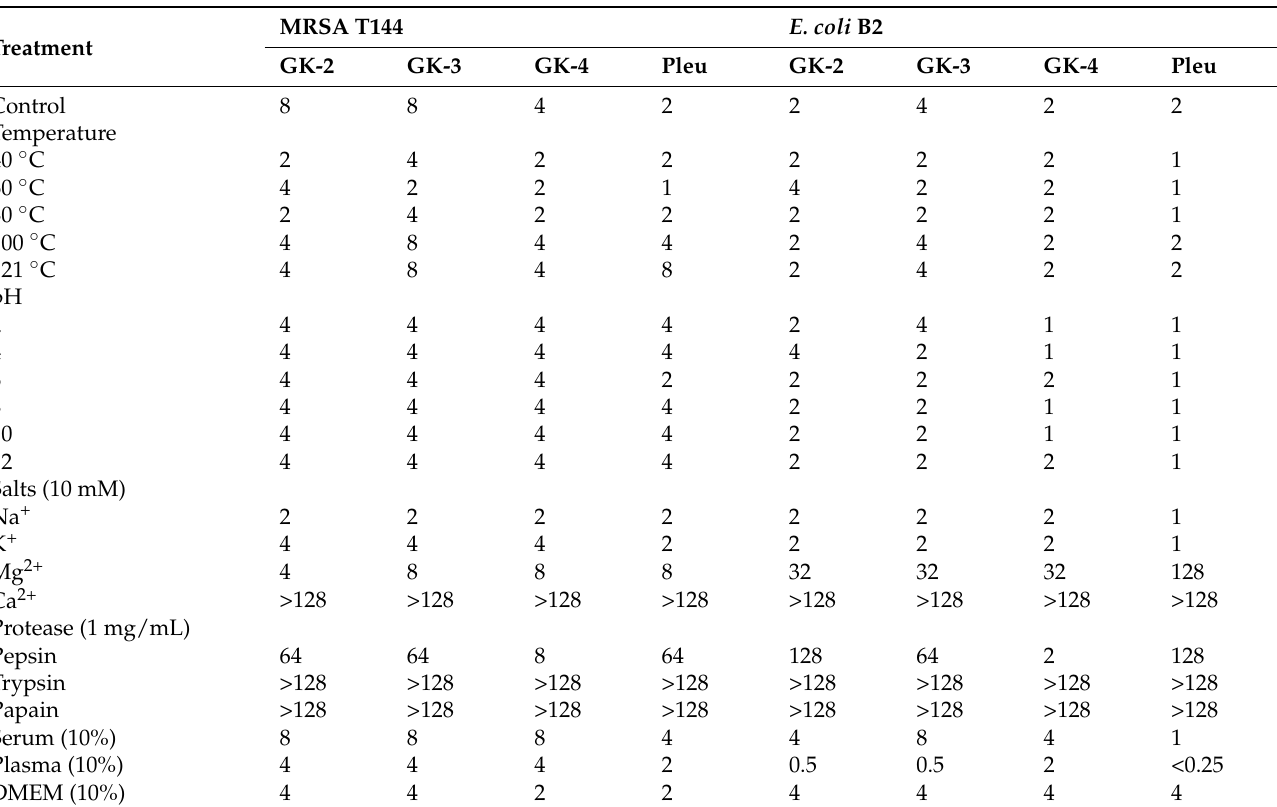
Table 3. Thermal, pH, salts and protease stability of Pleu and its modified peptides against MRSA T144 and E. coli B2 (MIC, µ g/mL).